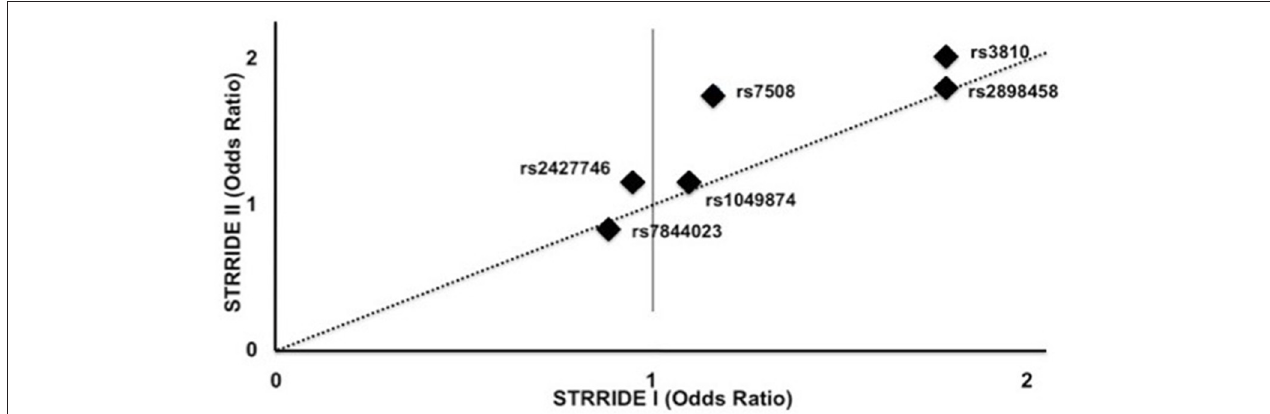
FIGURE 3 | Genotype effect on odds of failure to complete study by SNP in STRRIDE II vs. STRRIDE I. Additive model odds ratios for risk of study non-completion for each ASAH SNP for STRRIDE I (x axis) and STRRIDE II (y axis). Two SNPs significantly increased the odds of failure to complete both STRRIDE II and STRRIDE I: rs2898458 and rs3810. SNP rs7508 significantly increased the odds of study non-completion in STRRIDE II.